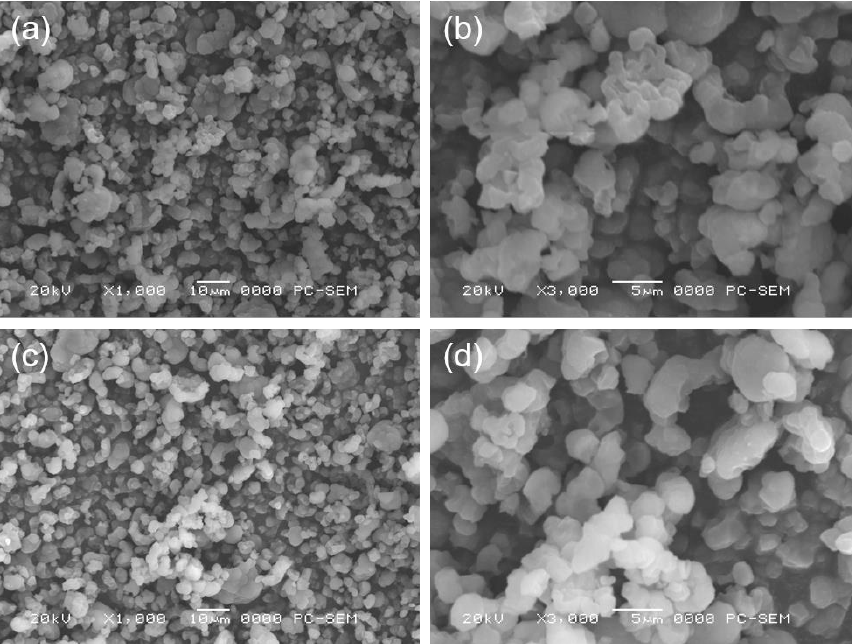
Figure 6. The SEM images of ( a ) Z–100 under a lower magnification, ( b ) Z–100 under a higher magnification, ( c ) Z–100–M under a lower magnification, and ( d ) Z–100–M under a higher magnification.